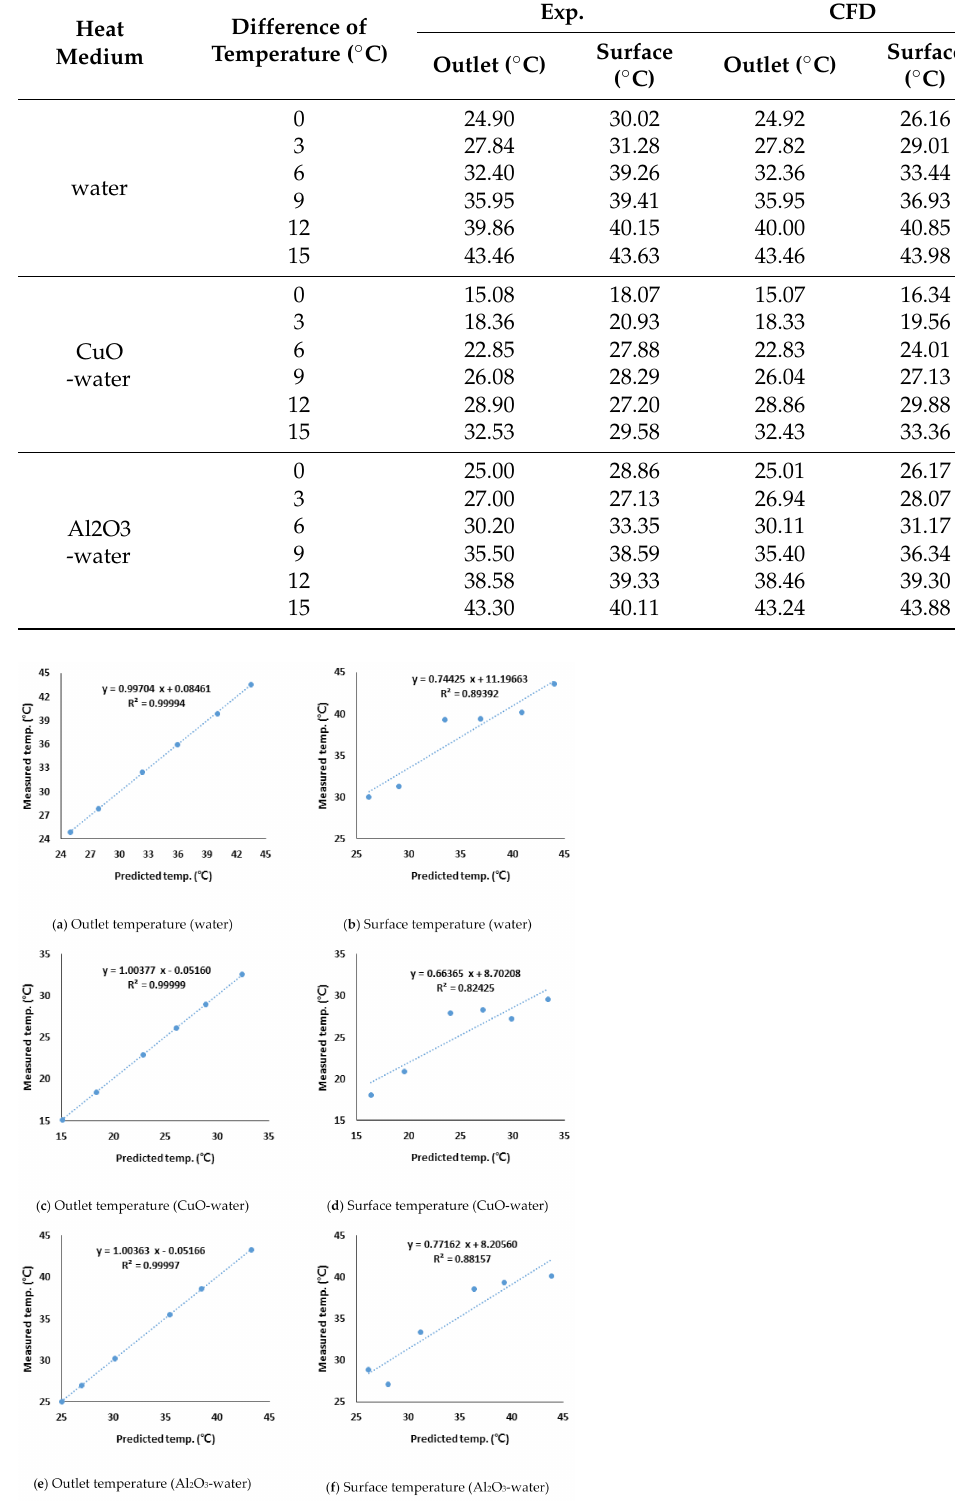
Figure 7. Predicted and measured values of outlet and surface temperature. Lines are 1:1. Where ( a ) indicates the Outlet temperature (water), ( b ) Surface temperature (water), ( c ) Outlet temperature (CuO-water), ( d ) Surface temperature (CuO-water), ( e ) Outlet temperature (Al 2 O 3 -water), and ( f ) Surface temperature (Al 2 O 3